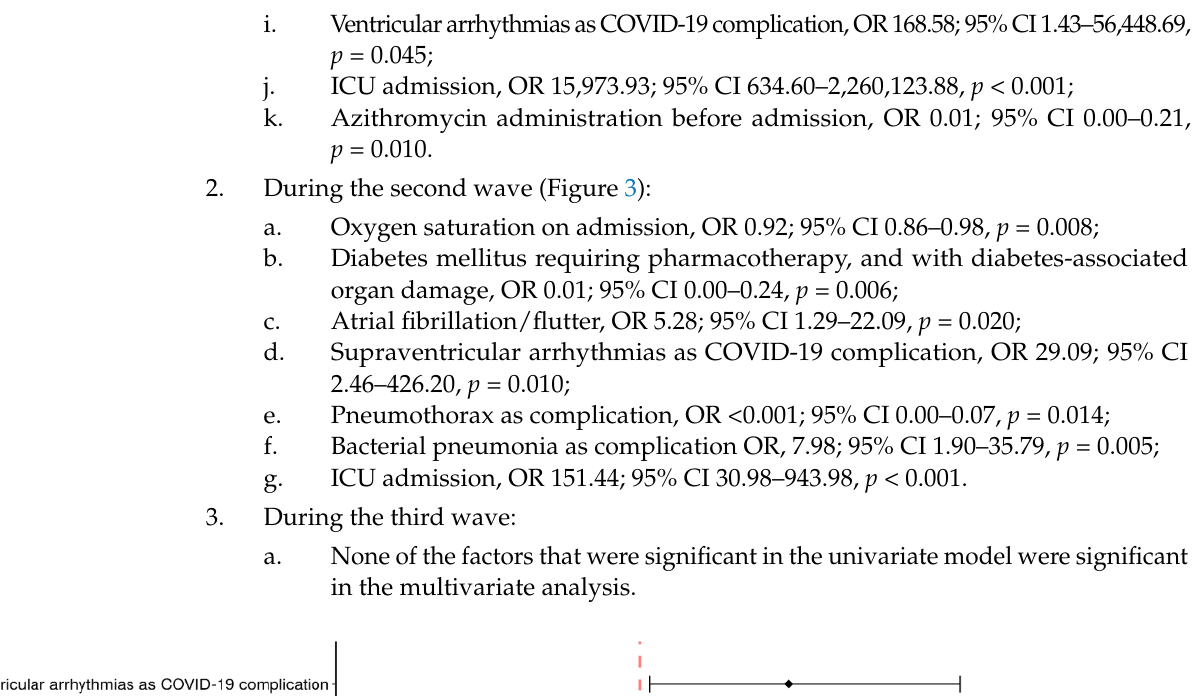
Figure 3. Multivariate logistic regression model analysis of the factors independently associated with death during the second COVID-19 wave in the Hospital for Infectious Diseases in Warsaw (Poland).